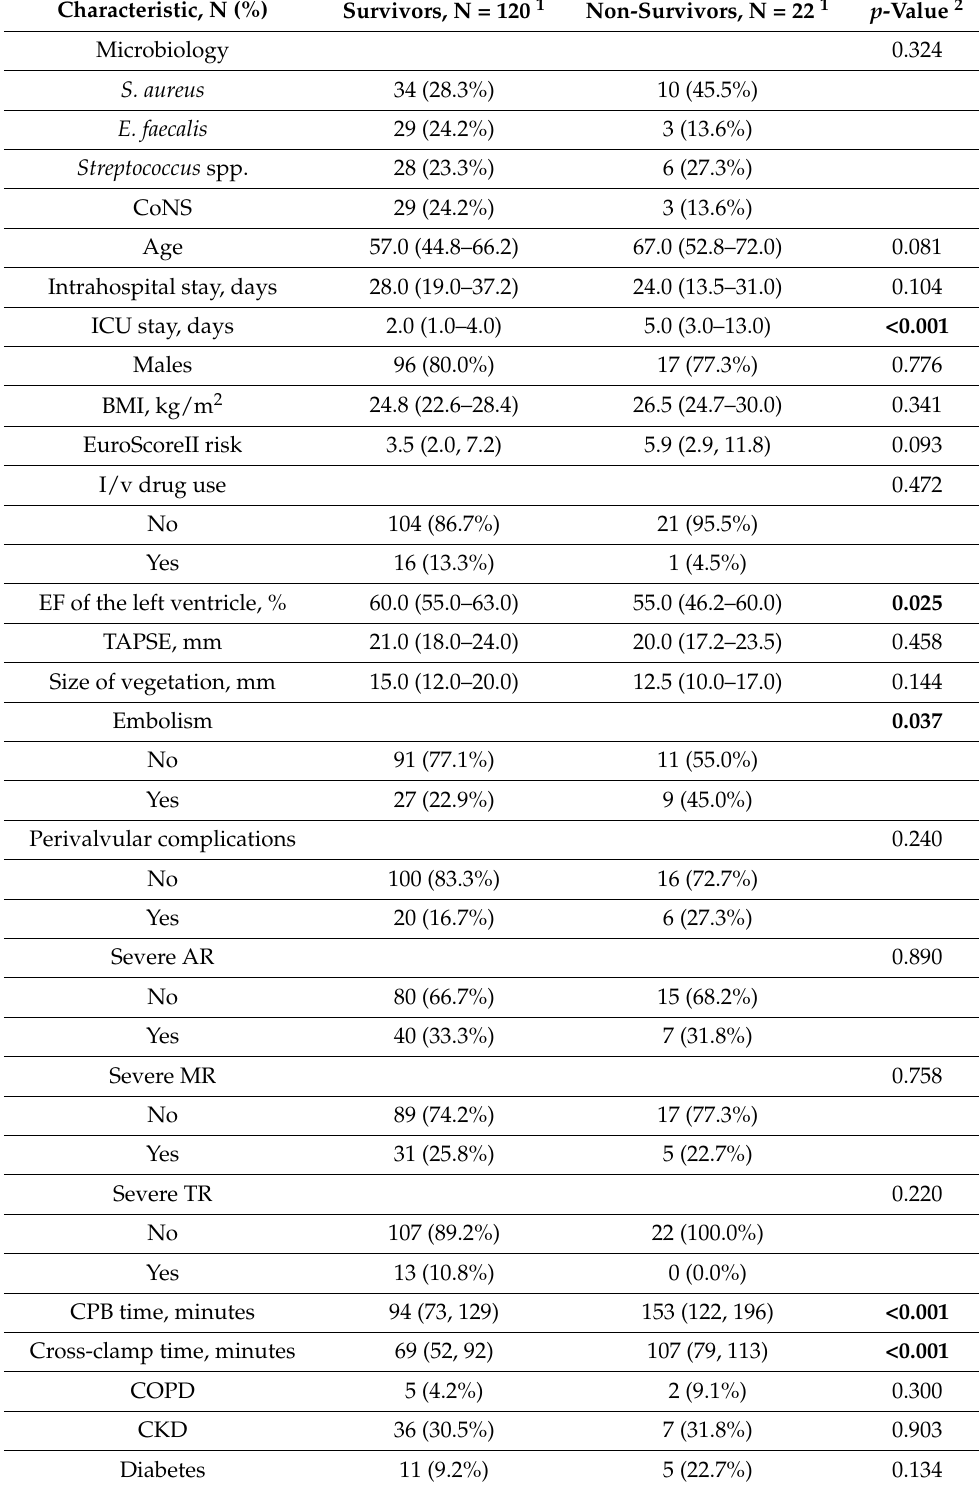
Table 6. Comparison of microbiology and other characteristics among survivors and non-survivors IE